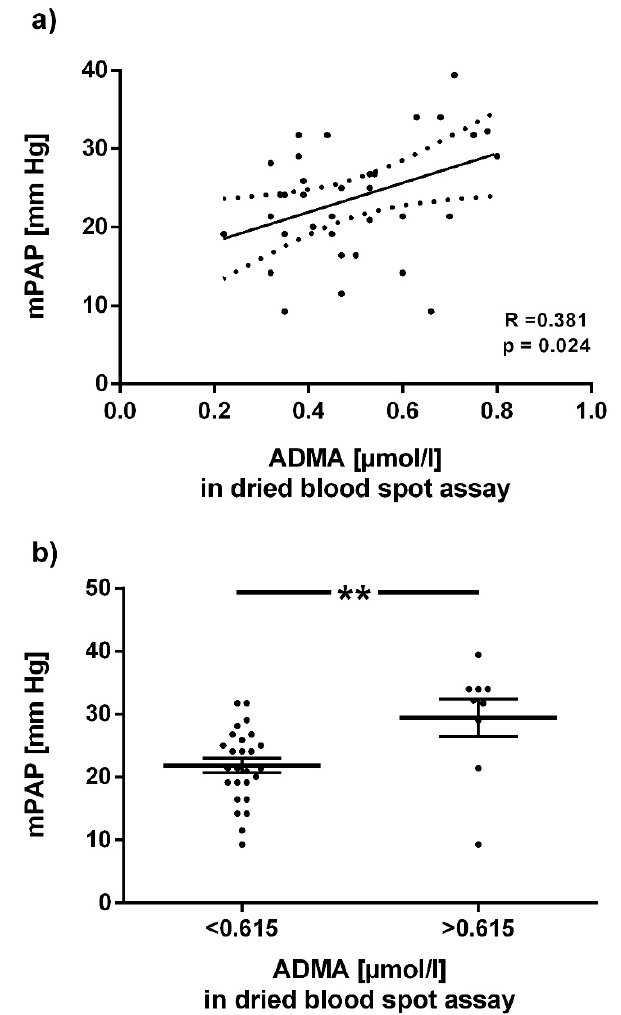
Figure 6. Association of baseline ADMA concentration in dried blood spots with mean pulmonary arterial pressure after 6 months of CIH. ( a ) Linear regression analysis of dried blood spot ADMA concentration at baseline with mean pulmonary arterial pressure (mPAP) after six months of exposure to chronic intermittent hypoxia (CIH). ( b ) Mean pulmonary arterial pressure (mPAP) at month 6 of CIH exposure in individuals with baseline dried blood spot ADMA concentration below or above o.615 µmol/L, the optimal cut-off for discrimination of the two groups in ROC analysis. Horizontal lines indicate mean ± SD; each dot represents one individual. ** p < 0.01 between groups.